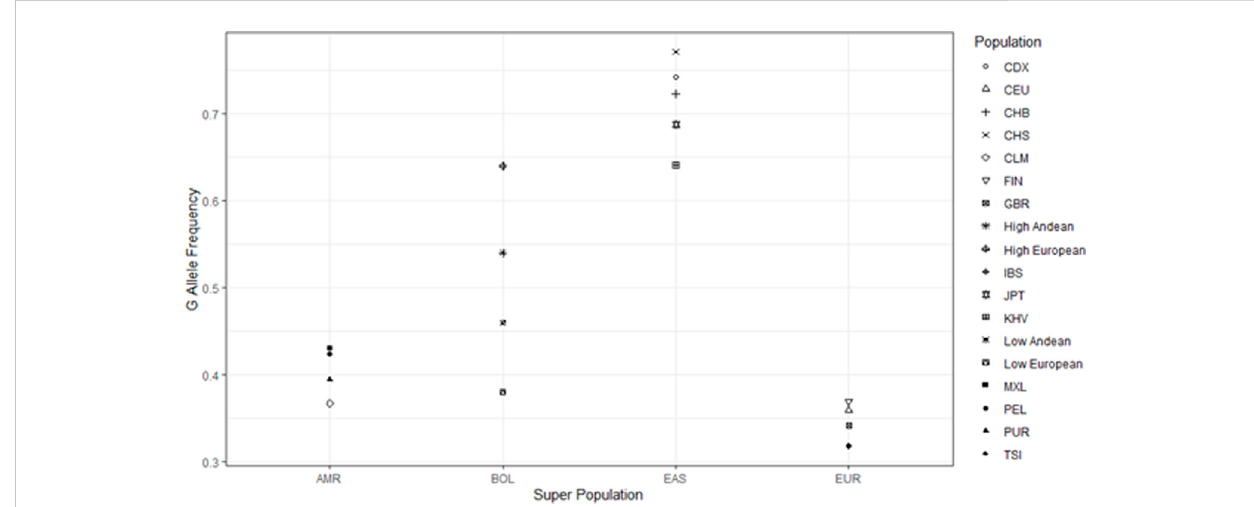
FIGURE 3 ComparisonsofAndeanallelefrequencyto1,000genomesdata.FigureshowsthecomparisonoftheGallelefrequencyamongourAndeansample populations in relation to the 1,000 genomes populations. AMR = Americans from the 1,000 genomes project, BOL = Samples from Bolivia residing at both high and low-altitude, EAS = East Asians from the 1,000 genomes project, EUR = Europeans from the 1,000 genomes project. The Populations include groups from the 1,000 genomes project (CDX = Chinese Dai, CEU = European from Utah, United States, CHB = Han Chinese from Beijing, CHS = Han Chinese from South China, CLM = Colombian, FIN = Finnish, GBR = British, IBS = Ibererian from Spain, JPT = Japanese, KHV = Vietnamese, MXL = Mexican from Los Angeles, PEL = Peruvian, PUR = Puerto Rican, TSI = Italian). We also included our 4 sample populations from Bolivia (High Andean = High altitude Andean, High European = High altitude European, Low Andean = Low altitude Andean, Low European = Low altitude